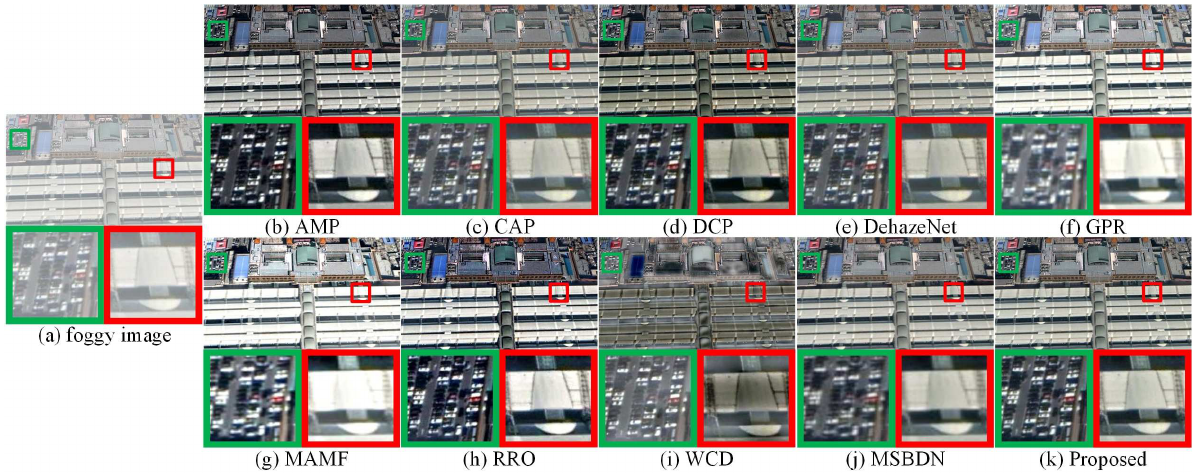
Figure 9. ( a ) shows a synthetic foggy remote sensing image. ( b – k ) respectively represent the defogged images obtained by AMP, CAP, DCP, DehazeNet, GPR, MAMF, RRO, WCD, MSBDN, and the proposed method. The two partially enlarged images marked in the green and red frames correspond to two areas enclosed by the green and red frames in each defogged image.